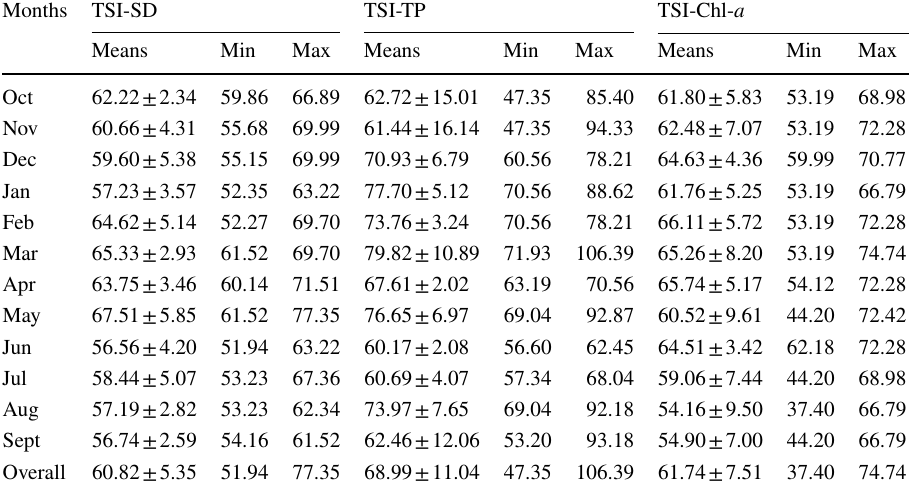
Table 5 Mean ± Std. Dev. and range values of the TSIs between sampling months ( n =